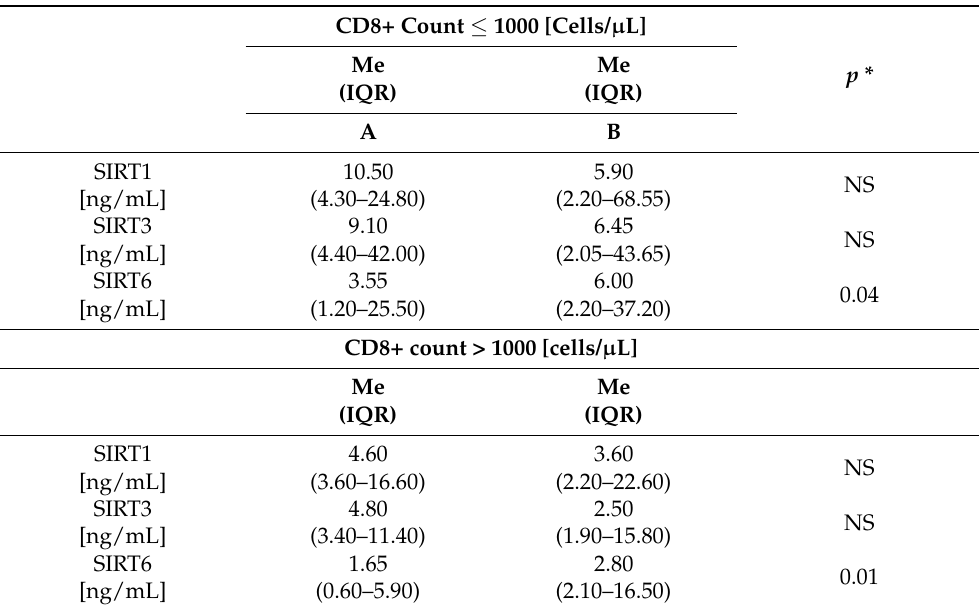
Table 5. Results for SIRT1, SIRT3 and SIRT6 in the plasma of HIV-infected men before cART ( A )